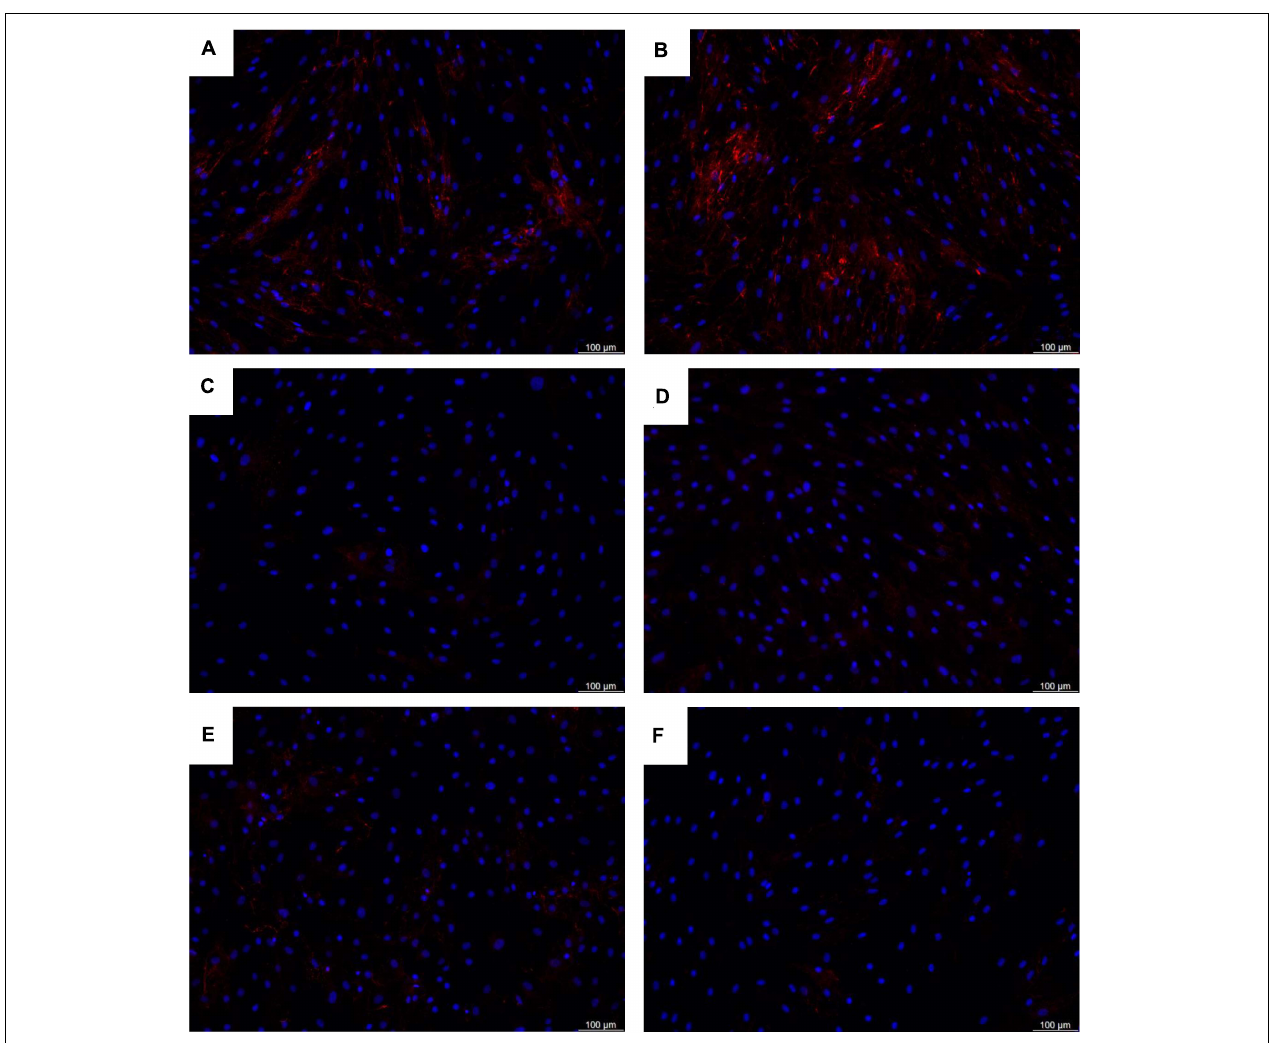
FIGURE 8 | Deposition of collagen type IV proteins in the extracellular matrix by (A,B) healthy control fibroblasts, (C,D) MBTPS2- OI patient fibroblasts, and (E,F) MBTPS2- IFAP/KFSD patient fibroblasts was determined by immunofluorescence staining. Collagen type IV proteins are depicted in red and nuclei are depicted in